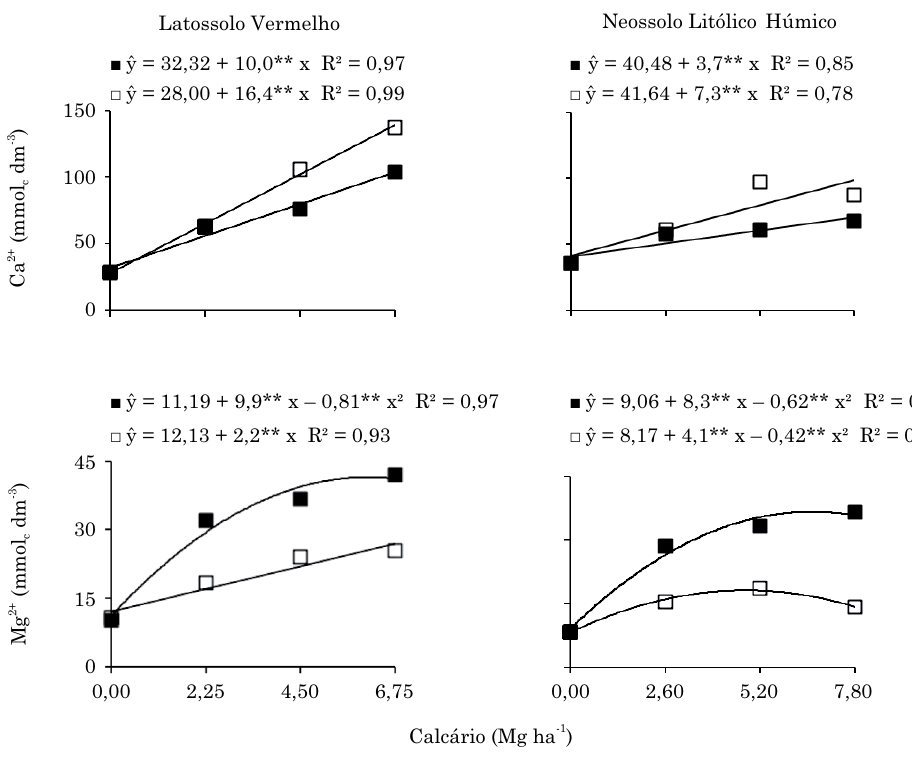
Figura 5. Alterações nos teores de Ca e Mg trocáveis da camada superficial (0,00-0,05 m) do Latossolo Vermelho Distrófico e do Neossolo Litólico Húmico, de acordo com as doses de calcário dolomítico (■) e calcítico (□) aplicadas na superfície em sistema plantio direto. Os valores são médias de duas faixas de prnt (B e d) dos corretivos. A calagem foi realizada em agosto de 2010, e as amostras de solo foram coletadas em agosto de 2011. **: significativo a 1